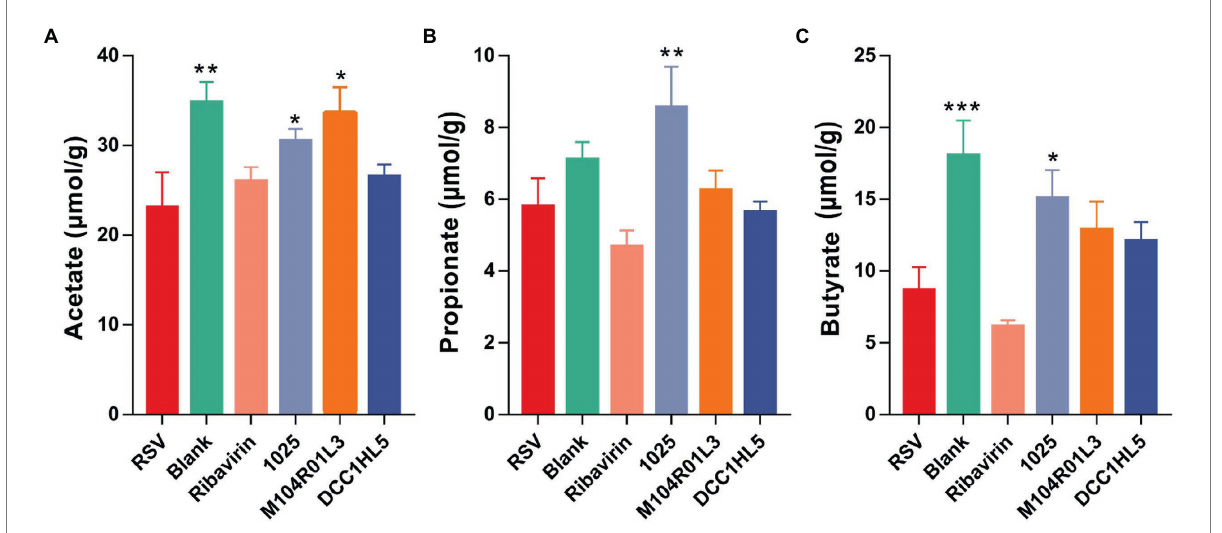
FIGURE 6 Levels of SCFAs in mouse ceca. (A) Acetate. (B) Butyrate. (C) Propionate ( n = 8. * p < 0.05, ** p < 0.01, *** p < 0.001 vs. RSV group). Error bars indicate the means ± standard error of the mean (SEM). Differences were compared using one-way ANOVA followed by Fisher’s LSD test. p values were adjusted using a false discovery rate. Blank, not infected with RSV. RSV, infected with respiratory syncytial virus and